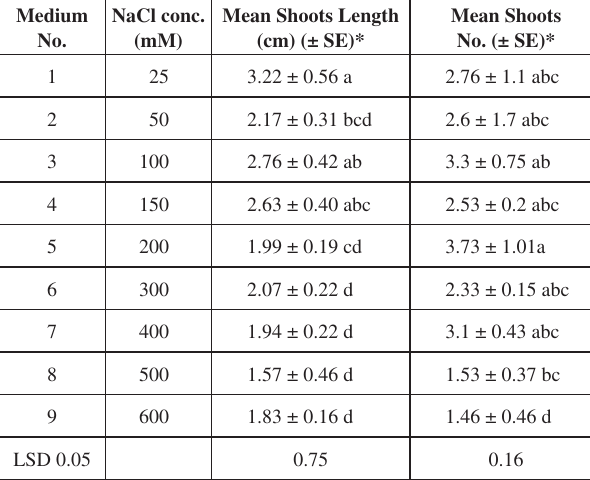
Table 3. Effect of NaCl concentrations on the number and length of shoots produced in vit ro in A. halimus L. within 4 weeks of culture Medium